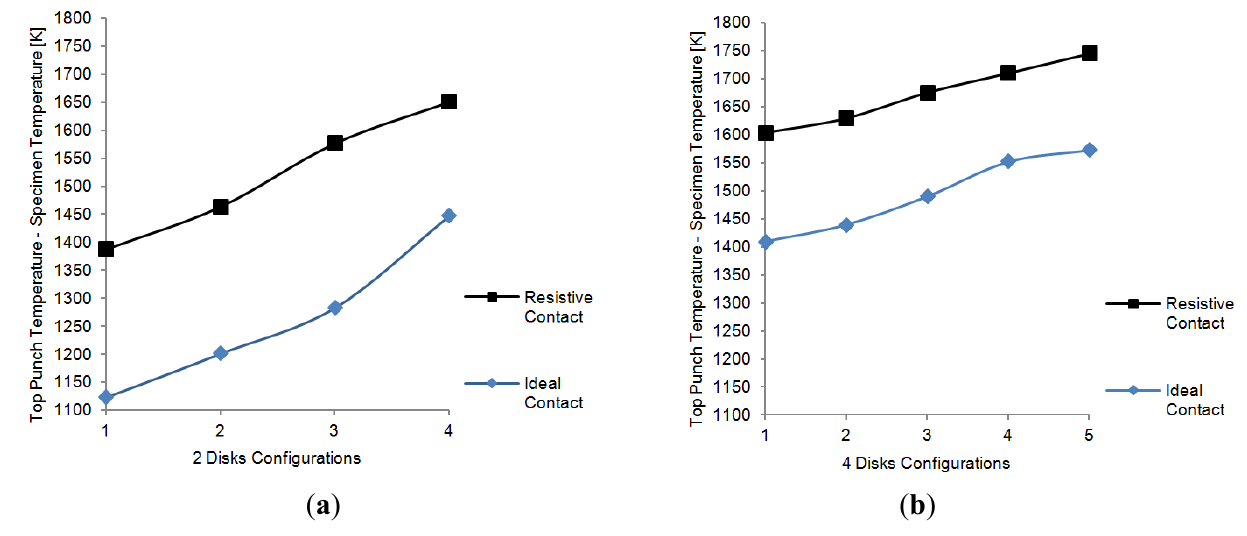
Figure 12. Comparison of maximum (transient) temperature difference between top punch and specimen. ( a ) two transitional disks configurations. Radii: (1) 50 and 25 mm; (2) 60 and 30 mm; (3) 65 and 35 mm; (4) 70 and 40 mm; ( b ) four transitional disks configurations—Radii: (1) 66, 54, 42, and 30 mm, (2) 68, 56, 44, and 32 mm, (3) 70, 60, 50 and 40 mm, (4) 75, 65, 55, and 45 mm; (5) 80, 70, 60, and 50